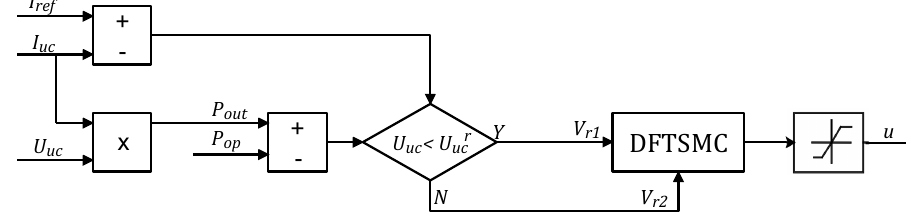
Figure 9. Charging strategy for the